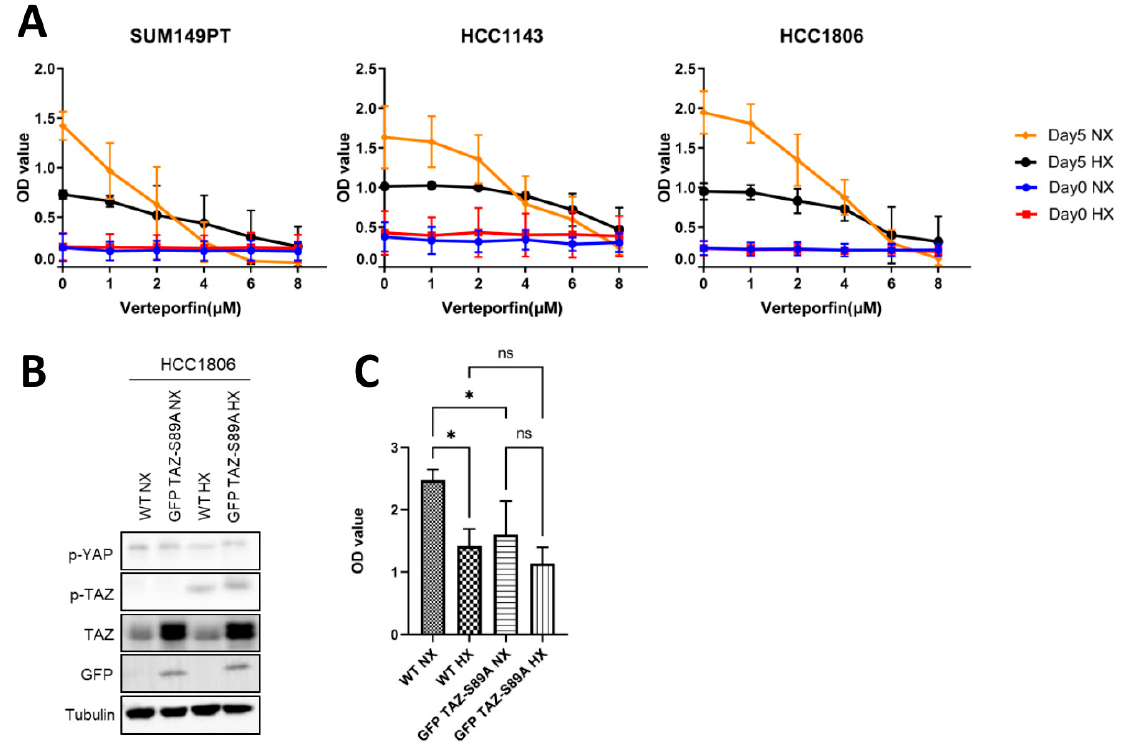
Figure 5. Effect of YAP/TAZ/TEAD complex inhibitor, verteporfin and expression of GFP TAZ- S89A in basal A cells. ( A ) Results of SRB assay for three basal A breast cancer cell lines at day 0 (indicating equal cell seeding densities) and after 5 days incubation under normoxia or hypoxia in presence of 0 (DMSO vehicle control), 1, 2, 4, 6 or 8 µ M Verteporfin. Mean of raw OD values and SD for three biological replicates is shown. ( B , C ) GFP TAZ-S89A HCC1806 cells and wildtype HCC1806 cells (WT) were incubated under normoxia and hypoxia for 5 days and analyzed by Western blot ( B ) or SRB assay ( C ). For SRB assays, mean and SD of OD values from three biological replicates performed in triplicate are shown. ns, non-significant; *, p < 0.05; ns, not significant. 2.6. Basal A Specific TAZ (Ser89) Phosphorylation Is Accompanied by Cytoplasmic Localization in Hypoxia